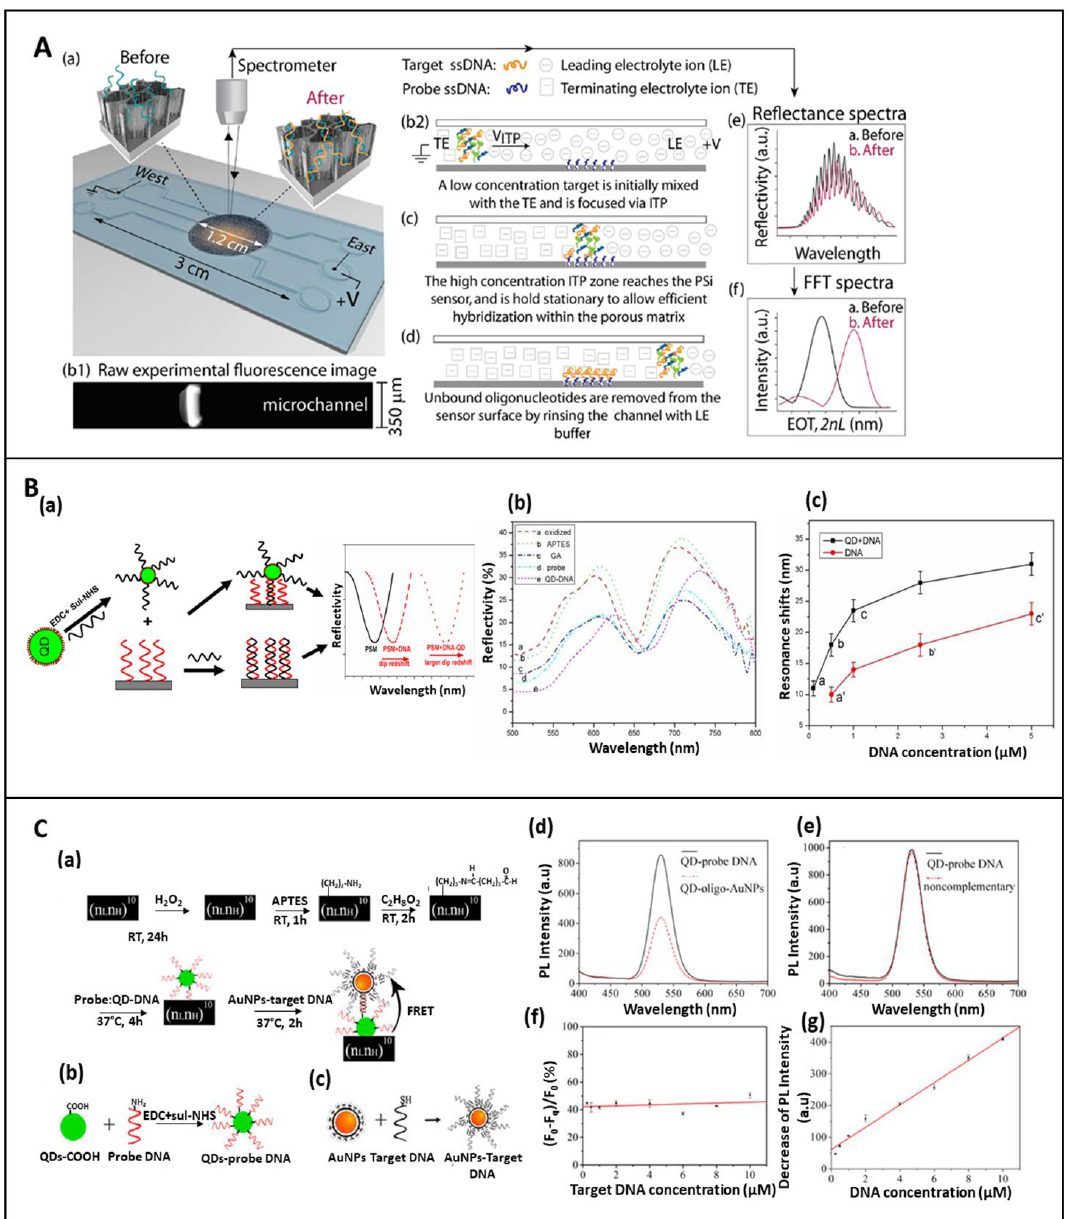
Figure 6. ( A ) (a) Scheme of the integrated PSiO 2 interferometric biosensor combined with the ITP technique into a microfluidic system; (b–d) scheme of the concentration process of target DNA (ssDNA) under ITP, followed by binding with immobilized DNA probe; (e,f) reflectivity spectra and corresponding FFT before and after DNA hybridization. Reprinted with permission from reference [100]; Copyright (2015) Wiley-VCH. ( B ) (a) Schematic representation of the sensing principle—the hybridization between target QDs-DNA and the complementary sequence, immobilized into PSi microcavity, causes a huge red-shift of the reflectivity spectra, increasing the response signal; (b) reflectance spectra after each functionalization steps; (c) relationship between the of QDs-DNA and control DNA at different concentrations and reflectance spectra. Reprinted with permission from Reference [101] https://creativecommons.org/licenses/by/4.0/ (accessed on 16 December 2020). ( C ) (a) Functionalization steps and sensing mechanism of QDs-AuNPs FRET biosensor for DNA detection; (b) DNA conjugation to QDs, and (c) DNA conjugated to AuNPs; (d) PL emission of QDs embedded in PSi matrix before and after hybridization with AuNPs-DNA; (e) control experiment performed by using AuNPs-conjugated with non-complementary DNA; (f) quenching efficiency Q = 1 − F q /F 0 with several DNA target concentrations; and (g) linear relationship between decrease of PL intensity and different AuNPs-target DNA. Reprinted with permission from Reference [103]. https://creativecommons.org/licenses/by/4.0/ (accessed on 24 January